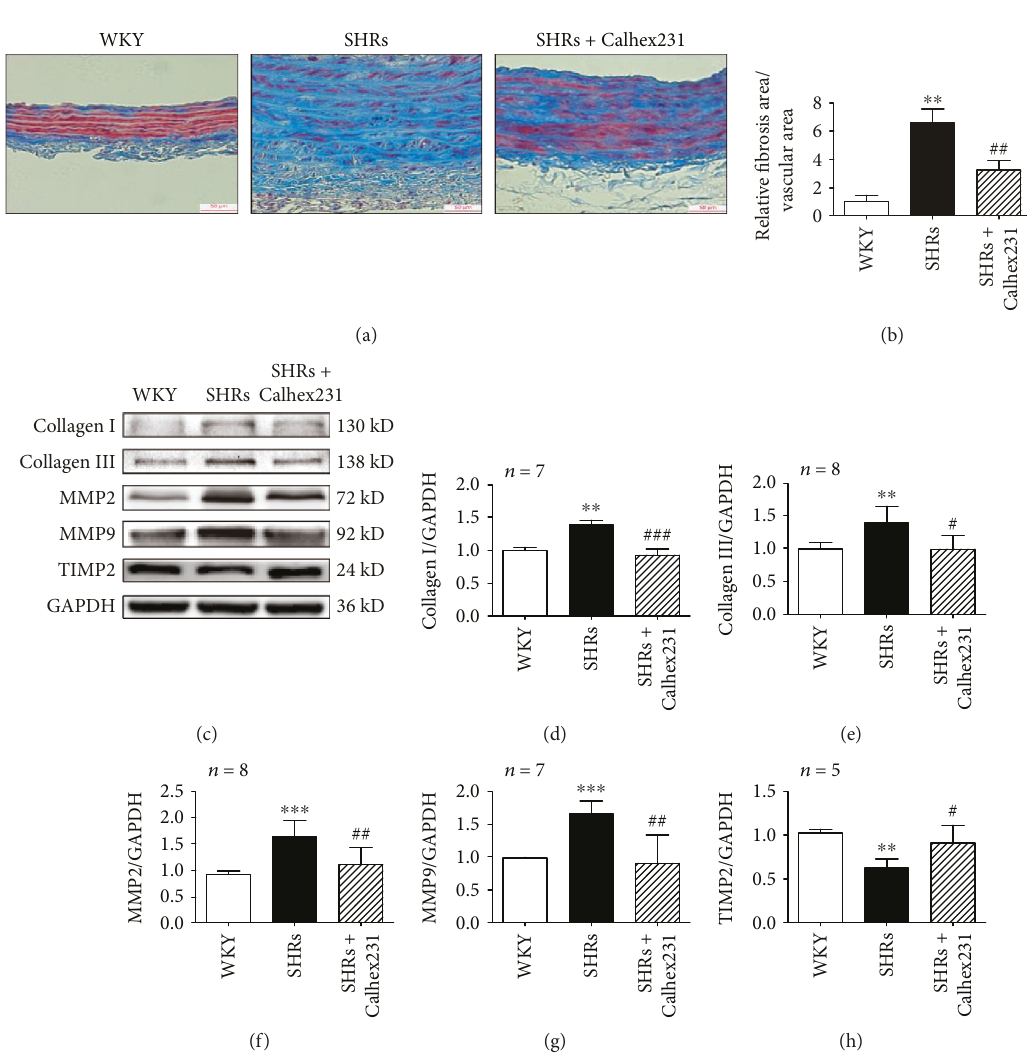
Figure 2: Suppression of CaSR prevented aortic fi brosis in SHRs. (a) Masson staining was used to detect aortic fi brosis, bar =50 μ m, n = 5 . (b) Quanti fi cation of the fi brosis area to vascular area of these arteries. (c) Western blots of collagen I, collagen III, MMP2, MMP9, and TIMP2 expressions. (d – h) Quantitative analyses of the proteins from C. ∗∗ P < 0 01 and ∗∗∗ P < 0 001 vs. WKY; # P < 0 05 , ## P < 0 01 , and ### P < 0 001 vs .